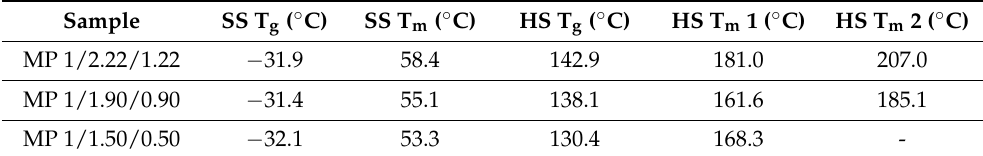
Table 6. Summary of the DSC results for the prepared bio-based